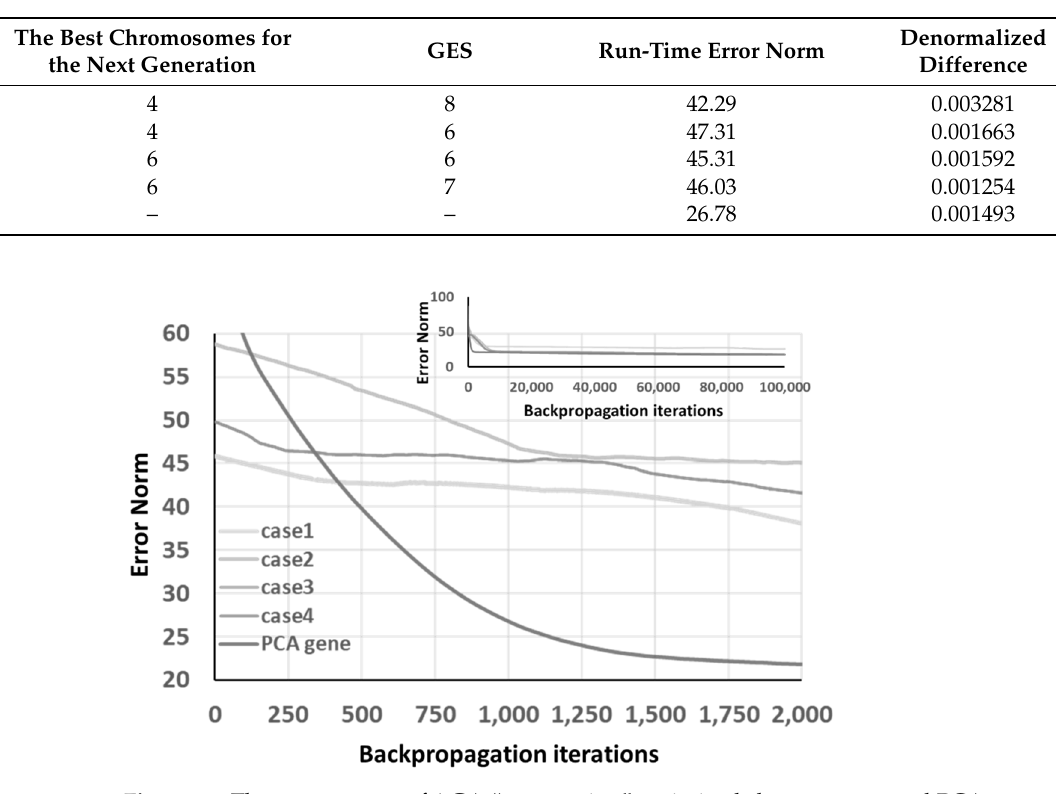
Table 7. The RNN training result under GA “progressing” optimizer.